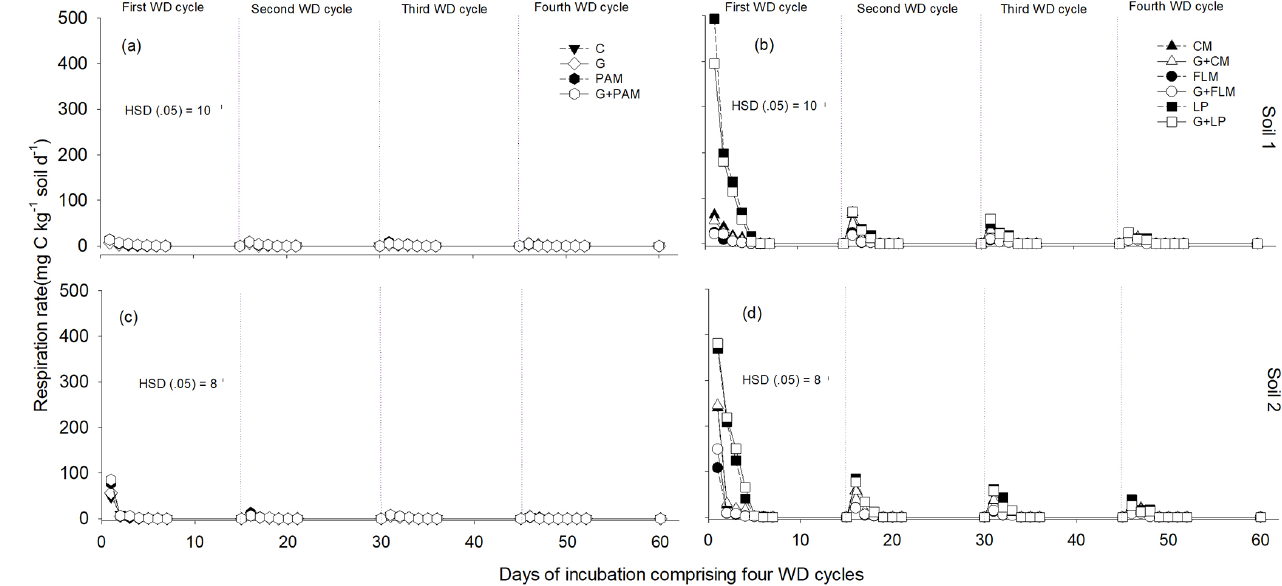
Figure 4. Changes in soil respiration rate after addition of amendments during four alternate WD cycles, Soil 1 (a, b) and Soil 2 (c, d) . The treatments were C: control, G: gypsum, PAM: anionic polyacrylamide, G + PAM: gypsum + anionic polyacrylamide, FLM: feedlot manure, G + FLM: gypsum + feedlot manure, CM: chicken manure, G + CM: gypsum + chicken manure, LP: lucerne pallets, and G + LP: gypsum + lucerne pallets. Vertical bars represent Tukey’s honest significant difference (HSD) values at p = 0 . 05 for pairwise comparisons among the four WD cycles. The vertical dotted lines show the days when deionized water was added to start the next WD